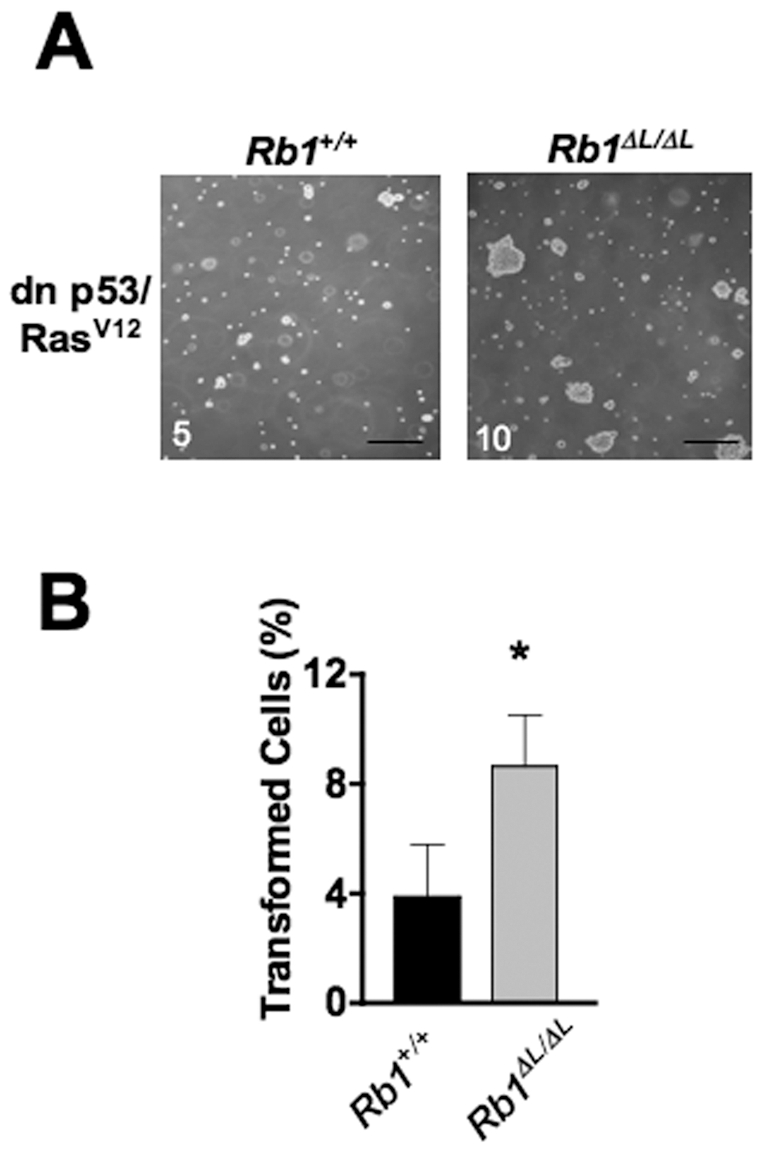
The Rb1ΔL mutation confers sensitivity to oncogenic transformation.A) MEF cells corresponding to the indicated genotypes were transduced with retroviruses expressing dominant negative (dn) p53 and RasV12 and plated in soft agar to allow colonies to form. Photomicrographs were taken after a two-week growth period. Number in the bottom right corner of each photomicrographs indicate the number of colonies that contained 5 or more cells. Scale: 200 µm. B) The percentage of wild type and mutant cells that transformed and grew into a colony was calculated from five randomly photographed microscopic images. A cell was counted as transformed if it formed a colony whose size appeared to be at least 5 cells. * indicates a statistically significant difference (Student's t test; P<0.005). Error bars indicate one standard deviation from the mean for at least three replicates.